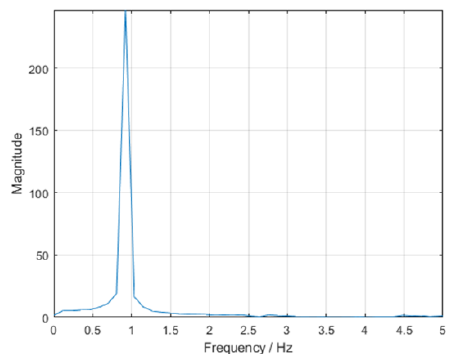
Figure 11. Frequency spectrum of the signal after the FFT. The dominating frequency can be found at 0.920 Hz, which corresponds to a period duration of T = 1.086 s.